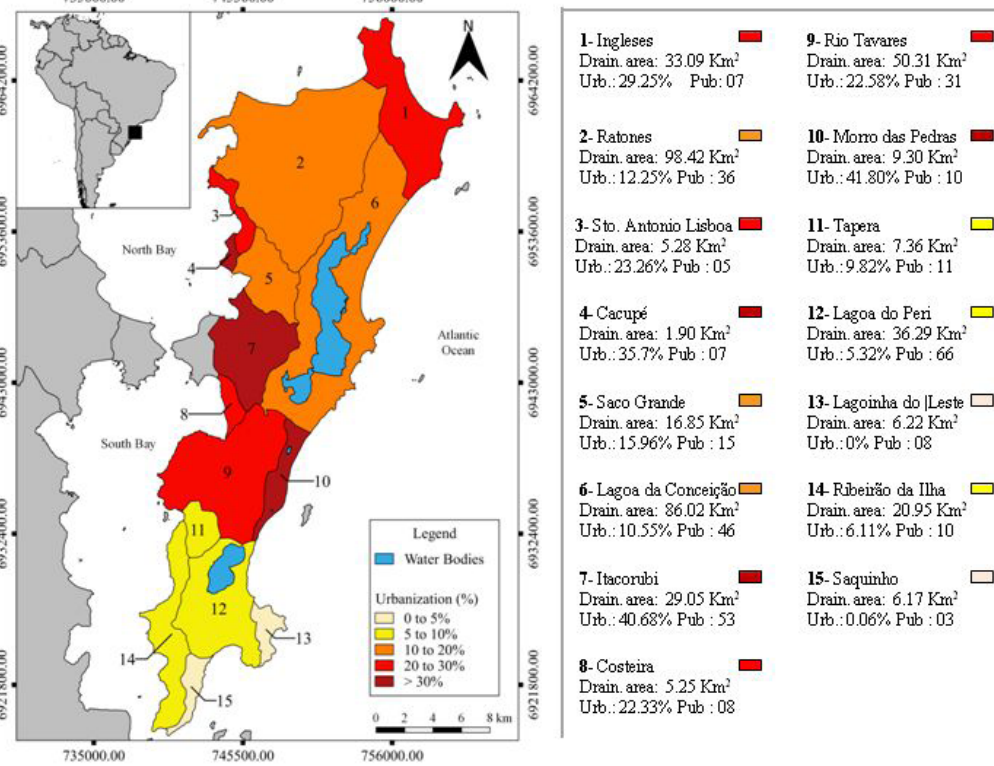
Figure 1. Study area map of the Santa Catarina Island - SC, Brazil. The watersheds are aggregated by urbanization gradient (beige: 0-5%; yellow: 5-10%; orange: 10-20%; red: 20-30%; dark-red: >30% of urbanization), drainage area and publications